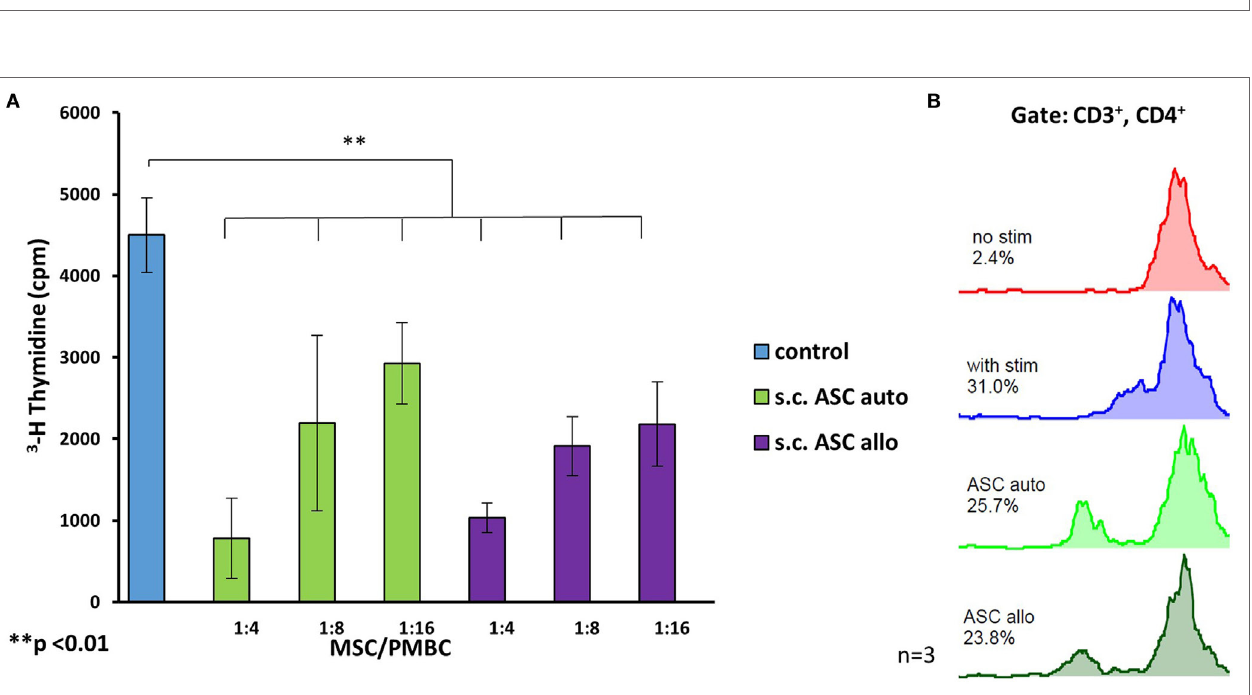
FigUre 4 | Specific stimulation of responder peripheral blood mononuclear cells (PBMCs) using irradiated splenocytes from a 6/6 mismatched donor resulted in a robust stimulation in controls ( n = 4, from different donors). The addition of s.c.ASCs, o.ASCs, and bone marrow-derived mesenchymal stem cells (BMSCs) resulted in a dose-dependent inhibition of responder cell proliferation (a) . At all ratios tested ranging from 1:4 to 1:16 between mesenchymal stem cell (MSC) and PBMC, there was a significant inhibition compared with stimulated responders alone ( p < 0.05), while there was no significant different between the different ratio steps. Analysis